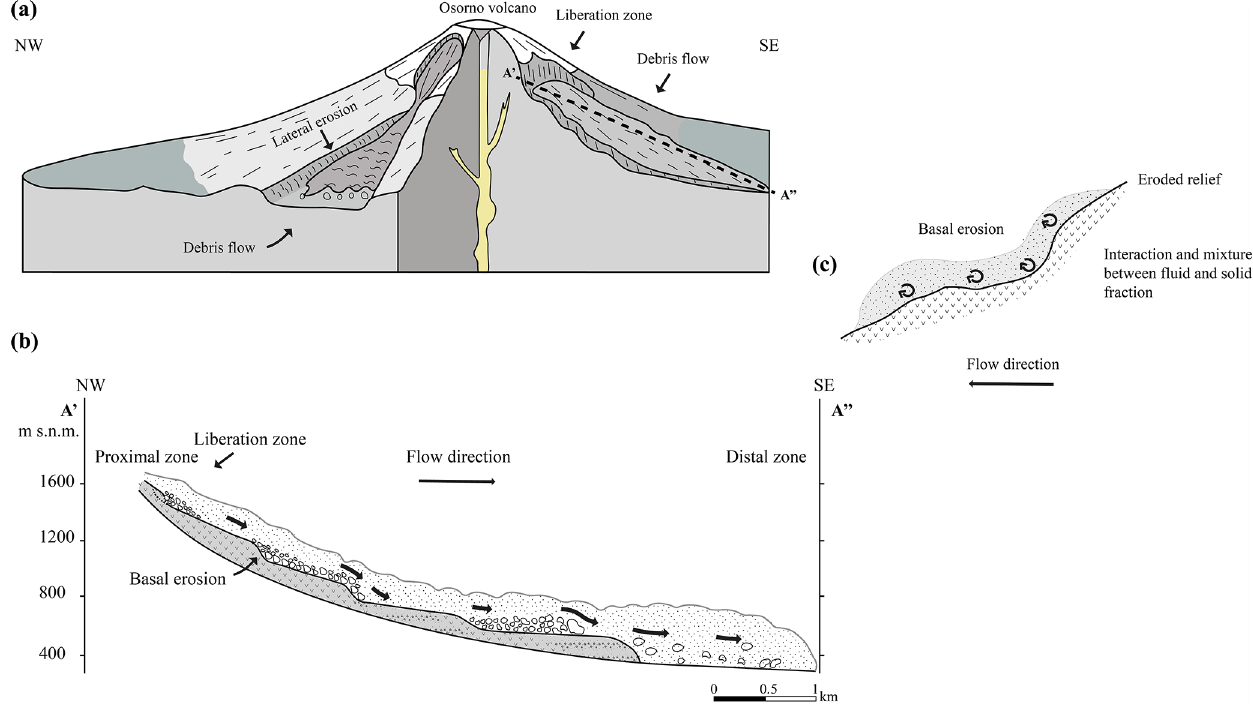
Figure 9. Conceptual model of chain processes in Osorno